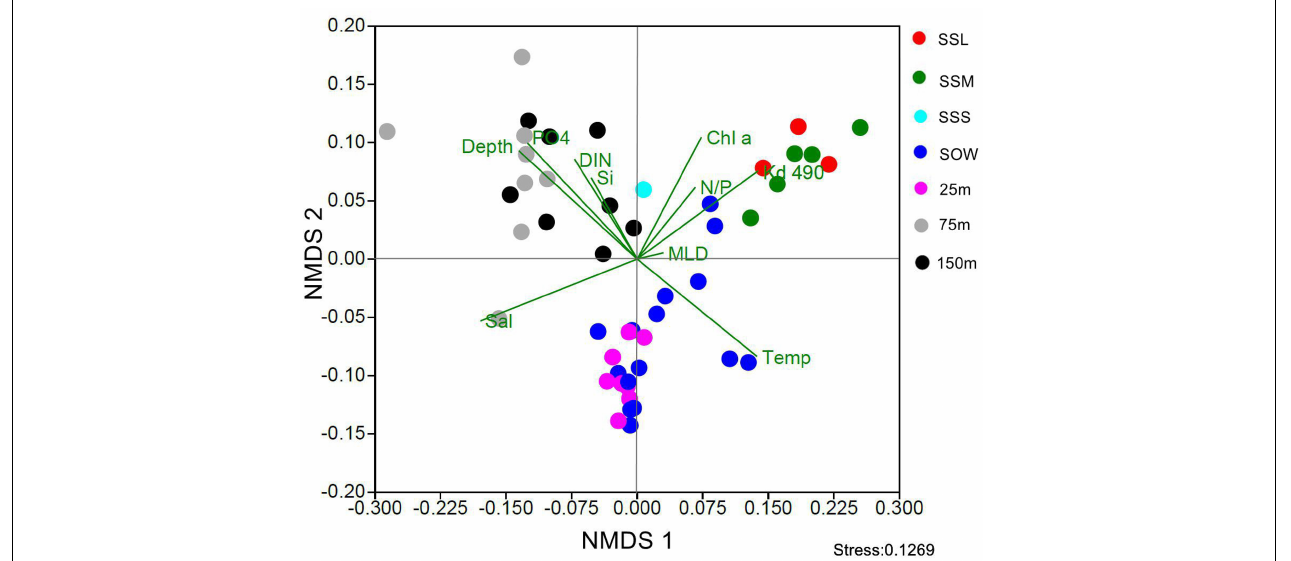
FIGURE 3 | NMDS analysis of community of Synechococcus pigment types in different depths and sampling stations (SSL, surface water of Sri Lanka coastal waters; SSM, surface water of Strait of Malacca; SSS, Surface water of station Shelf of Sunda; SOW, surface water of open water in EIO; Temp, temperature; Sal, salinity; DIN, dissolved organic nitrogen; PO4, phosphate; N/P, N/P ratio; Si, silicate; Chl a , chlorophyll a ; MLD, mixed layer depth; Kd490, the diffuse attenuation coefficients at 490 nm).